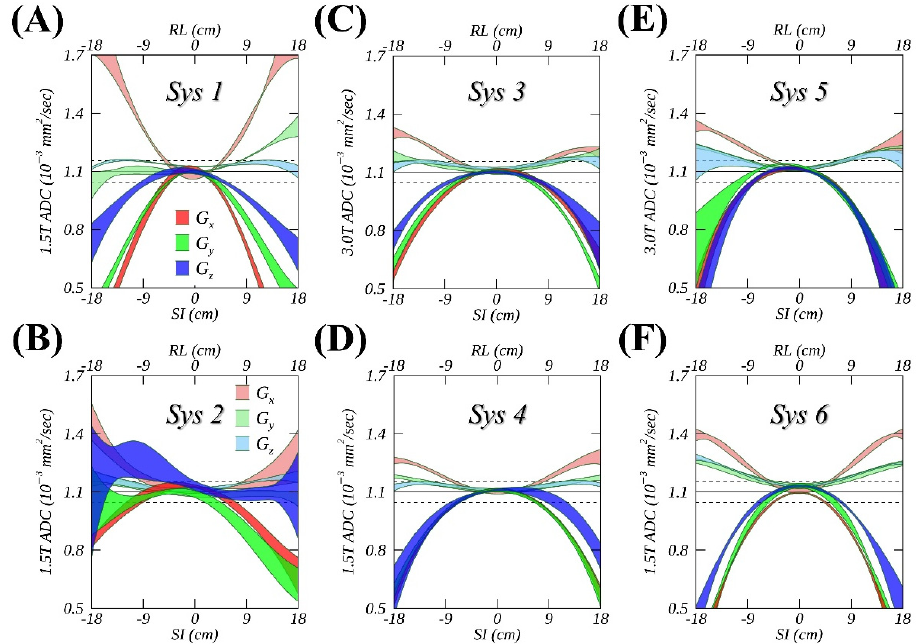
Figure 2. Spatial variations (colored ribbons representing temporal mean ± SD) of fitted ice-water apparent diffusion coefficient (ADCs) measured from longitudinal studies are shown as a function of a horizontal offset (light colors) and along the magnet bore (dark colors) for six different MR systems (Sys1-6) in ( A – F ), using three individual gradient channels G x (red), G y (green), and G z (blue). Solid and dashed horizonal lines mark an ice ‐ water ADC reference and its ± 5% deviations. From the same vendor, Sys1 (Figure 2A) considerably outperformed Sys2 (Figure 2B) at the same 𝐵 (cid:2868) field strength (1.5T), suggesting an insufficient measurement accuracy for Sys 2. An asymmetric ADC profile, with right offsets observed for 𝐺 (cid:3052) (light green) on Sys1, further revealed that non ‐ GNL sources contributed a substantial (~10%) amount to the observed ADC spatial bias for this specific gradient channel. Overall, more channel ‐ specific asymmetry (<5%) was observed for ADC profiles measured on 3T systems (Figure 2C,E) compared to 1.5T (Figure 2D,F), reflecting the fact that the observed incremental non ‐ GNL bias could not be sufficiently mitigated even with higher (i.e., 2nd) order shims. Several systems also exhibited a minor (< 3%) constant shift of the fit at zero offset for the slice ‐ select channel (e.g., Figure 2A,F, 𝐺 (cid:3053) and 𝐺 (cid:3052) ), which was consistent with finite cross ‐ terms with imaging gradients. Table 1. Summary of spatially averaged %𝑅𝑀𝑆𝐷 (cid:3036) ( 𝑖 (cid:3404) 𝑅𝐸𝐹,𝐸𝑋𝑃,𝑇𝑀𝑃 ) for horizontal (RL) and along ‐ the ‐ bore (SI) offsets of three physical (x, y, z) gradient channels and the trace (t) from six studied gradient platforms (Sys1 ‐ 6).